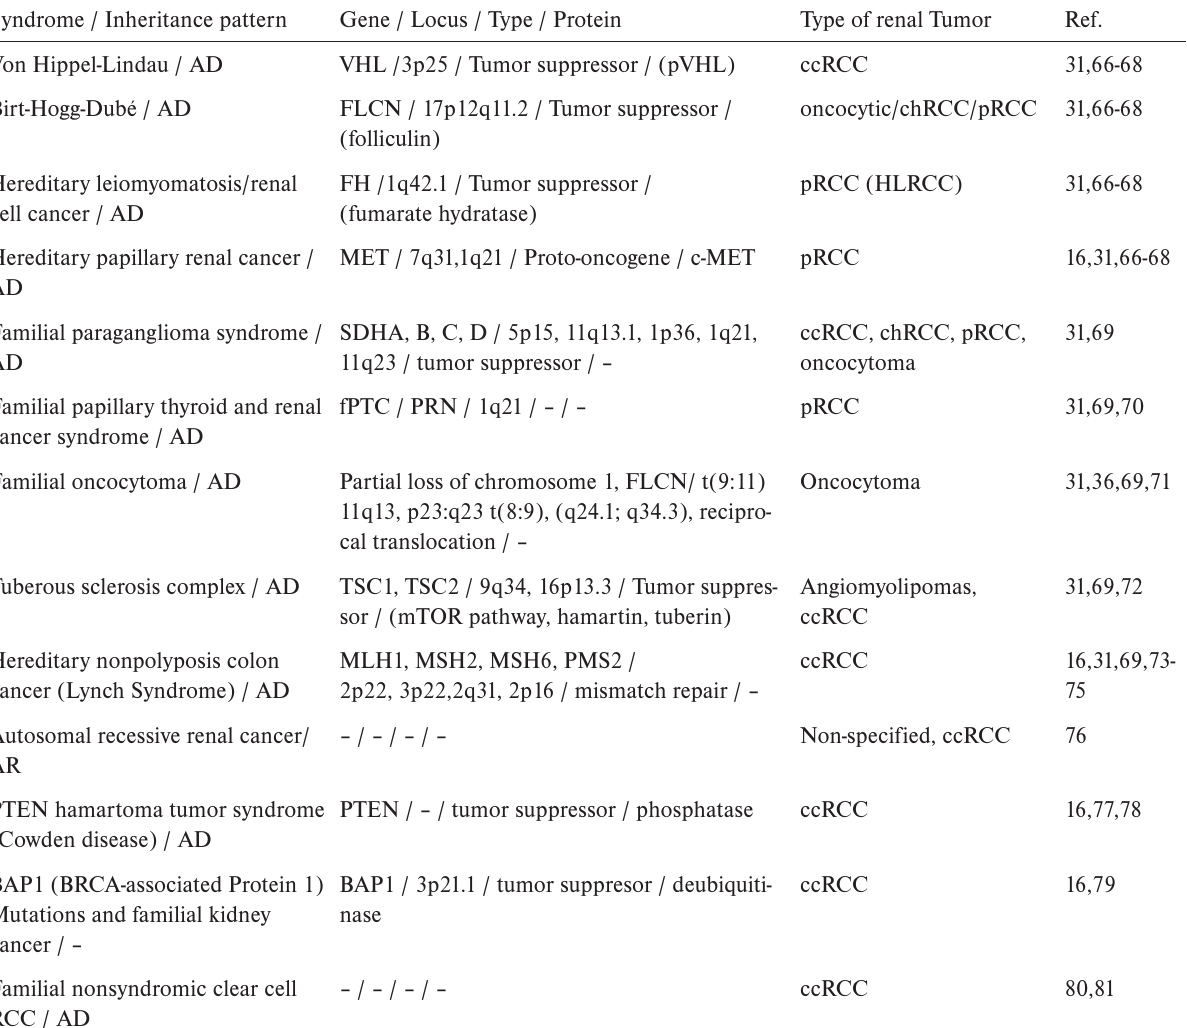
Table 1. Hereditary syndromes associated with renal